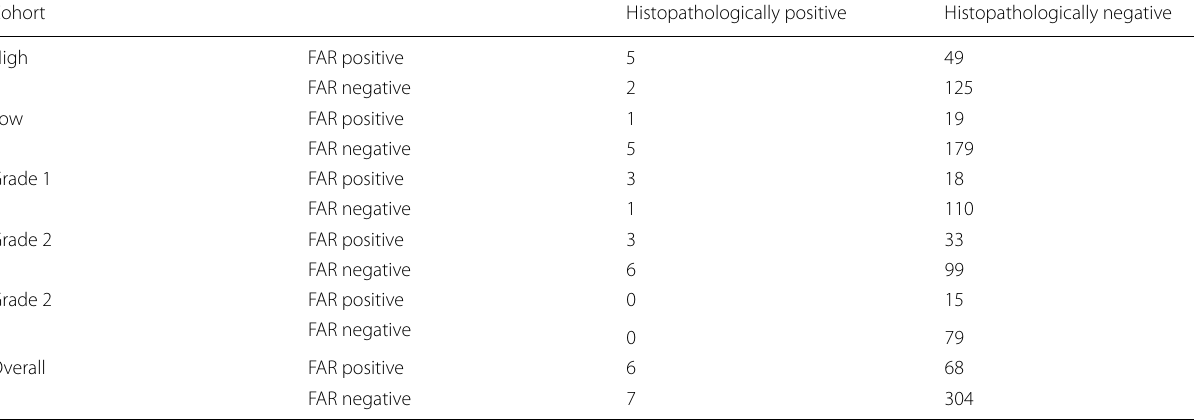
Table 2 Confusion matrix of FAR imaging for intraoperative margin assessment of intact WLE specimens compared to gold standard histopathology. Results are shown for the overall cohort as well as for subgroups based on the decay corrected [ 18 F]FDG activity